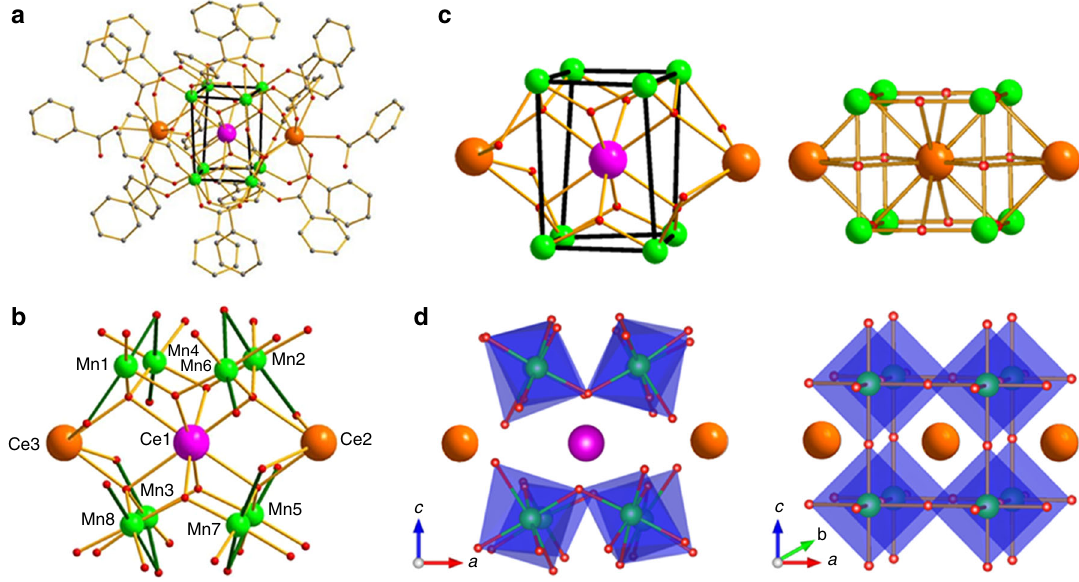
Fig. 1 The molecular structure of Ce 3 Mn 8 from experimental single-crystal X-ray diffractometry data. a The complete structure with H atoms omitted for clarity. The thicker black lines are guides to the eye to emphasize the distorted Mn 8 cube. b The partially labeled central fragment with the Mn III JT axes indicated as thicker Mn – O bonds. Color scheme: Ce IV purple ; Ce III and Ln III orange ; Mn III green ; O red ; C gray . c Comparison of the core from ( a ) of Ce 3 Mn 8 ( left ) with a repeating unit of an ideal ABO 3 cubic perovskite plus two A ions from adjacent repeating units ( right ). d As for ( c ) but showing the MnO